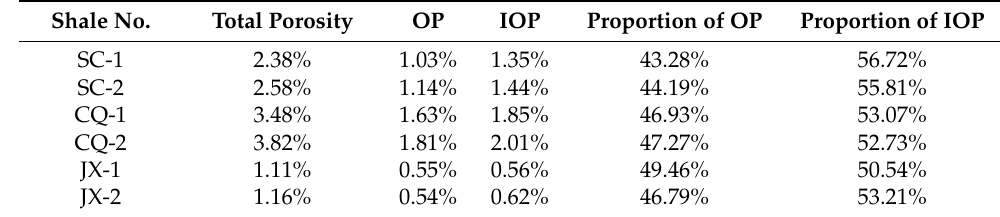
Figure 3. Size distributions of organic pores and inorganic pores in shale samples. Table 1. Organic porosity (OP) and inorganic porosity (IOP) of the investigated shale samples. Shale No.